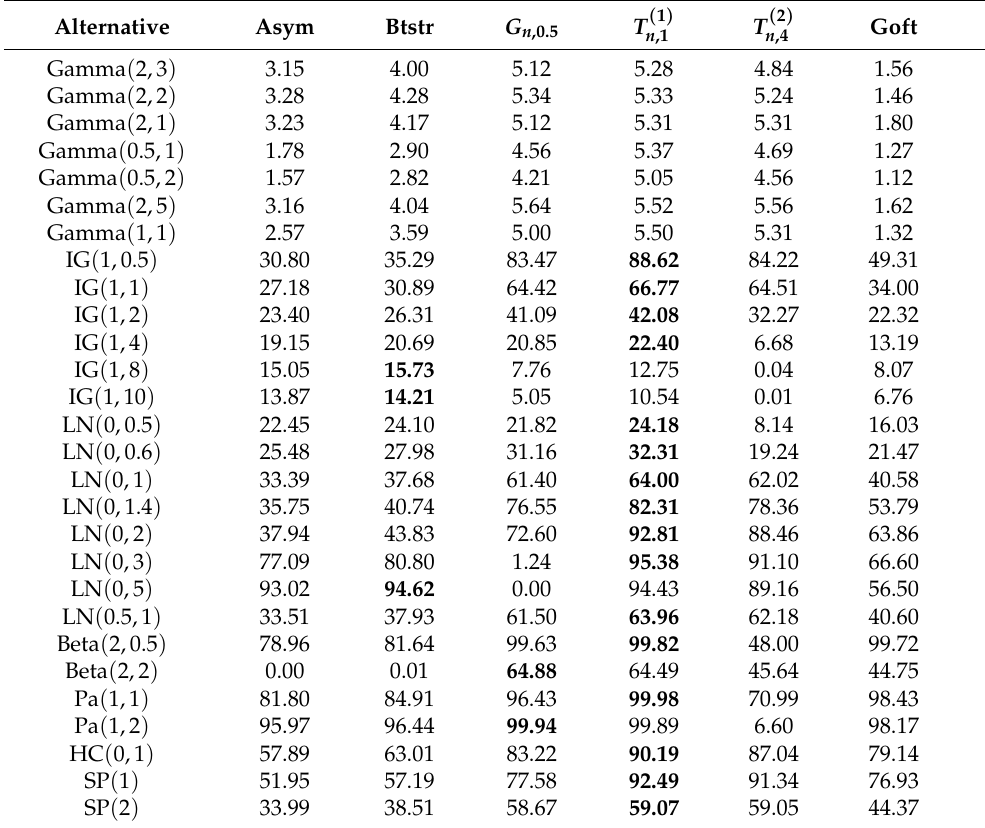
Table 1. Percentage of 10,000 Monte Carlo samples declared to be significant by various tests for the gamma distribution ( n = 50, α = 0.05). MLE ˆ ν was used.